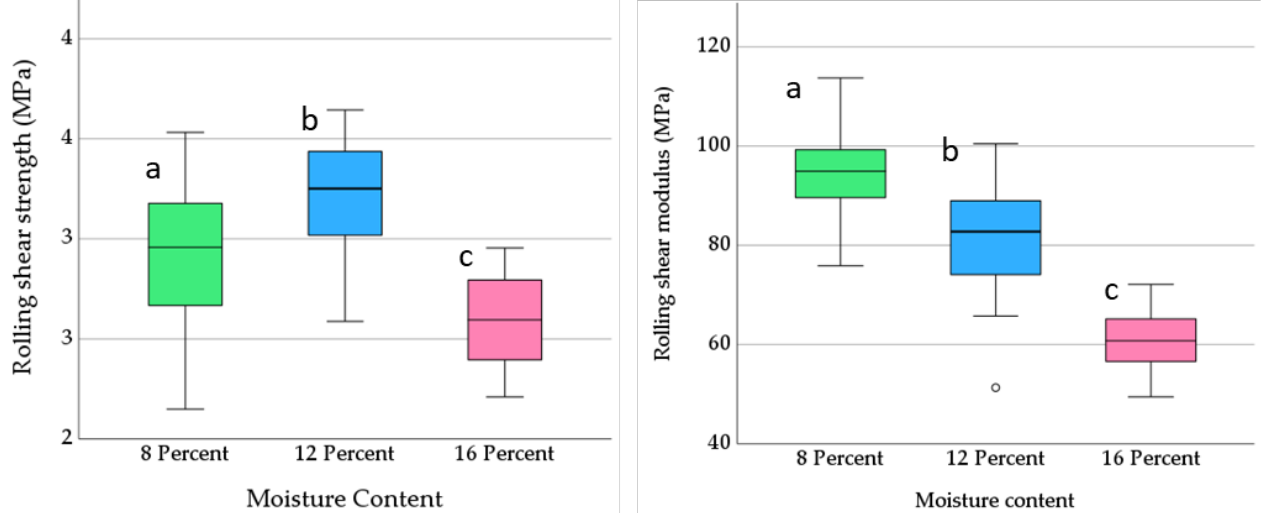
Figure 5. Boxplot showing effect of moisture content on RS strength ( left ) and modulus ( right ) of southern pine. The square in the boxplots shows the mean and different letter are from LSD test in the boxplots indicating the means between groups are significantly different ( p -value equals 0.05).